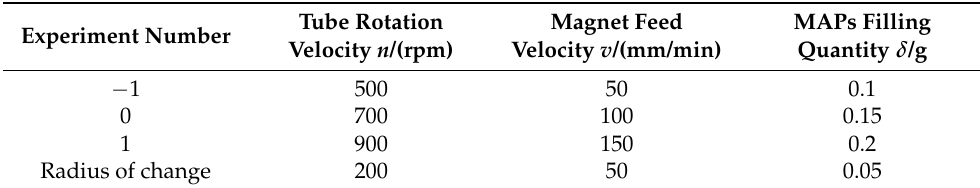
Table 4. Correspondence table of factor level and coding